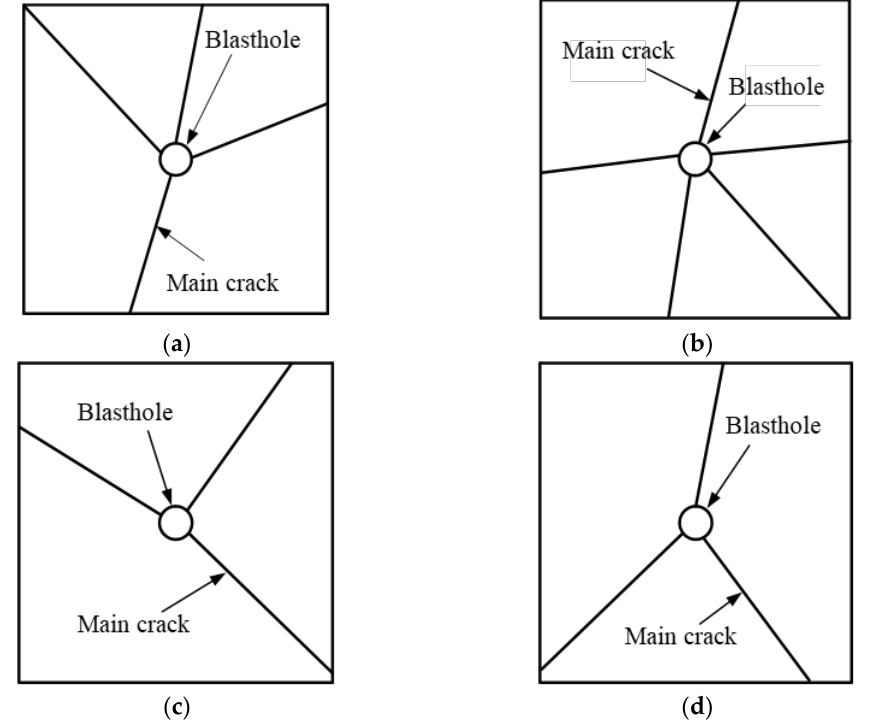
Figure 8. Shape of the main fracture and its distribution in Group A specimens. ( a ) Crack distribution of A-1 specimen; ( b ) Crack distribution of A-2 specimen; ( c ) Crack distribution of A-3 specimen; ( d ) Crack distribution of A-4 specimen.